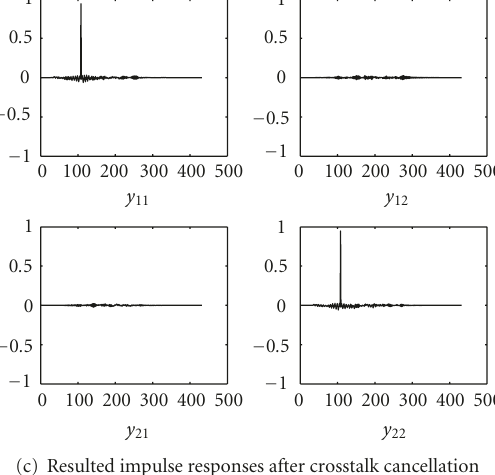
Figure 7: Impulse responses of crosstalk cancellation in the asymmetric